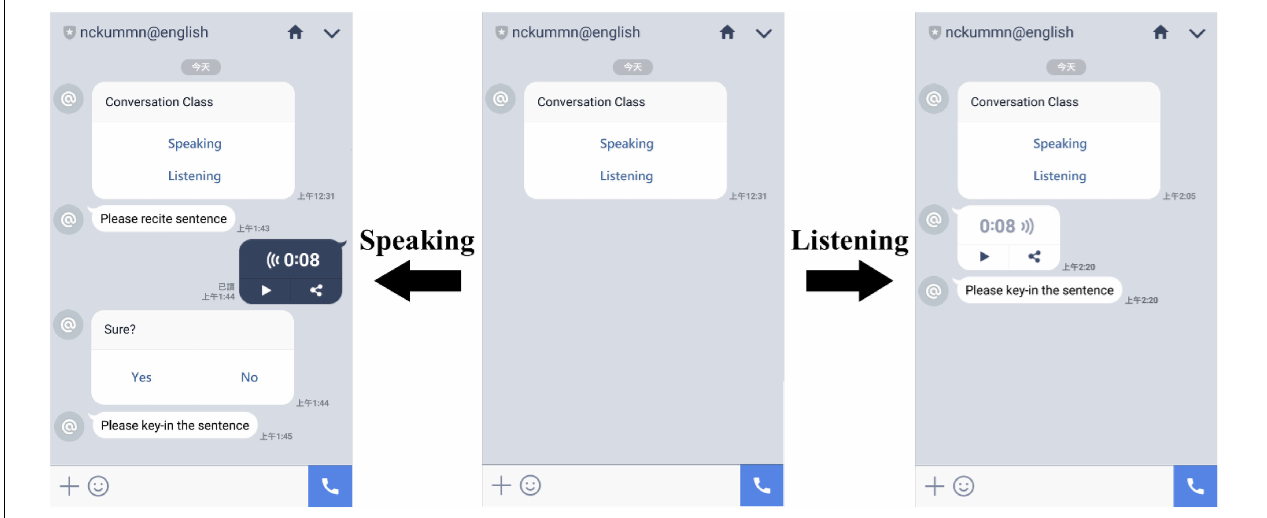
classroom teacher would then give feedback to the students on elements of their speaking performance, such as articulation, pronunciation, and tone. Students in the experimental group received additional scores related to the competition phase of the experiment.